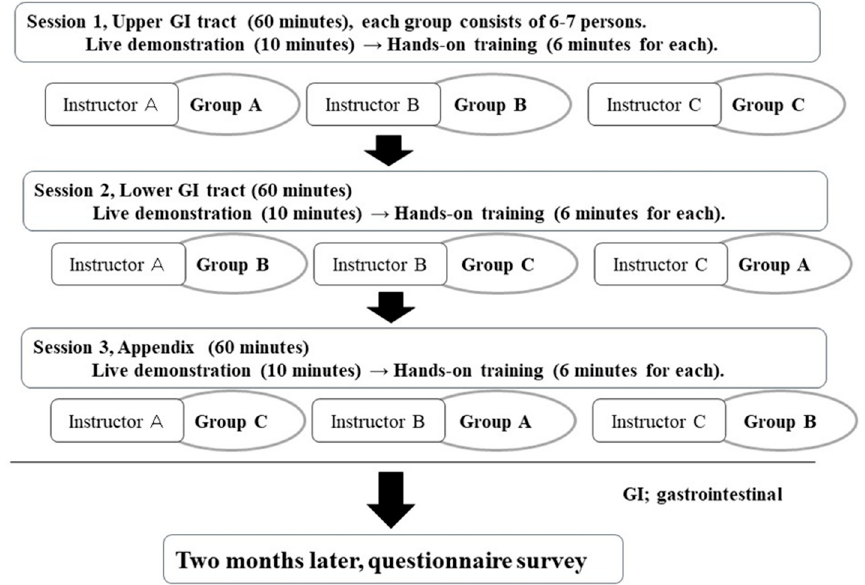
Figure 3. Flow chart of hands-on seminar and follow-up survey.